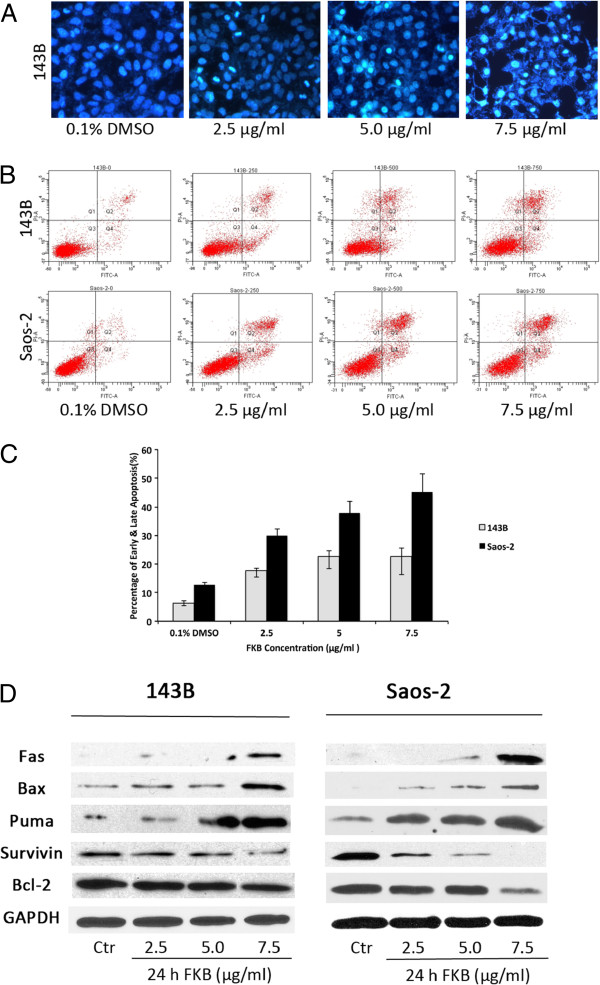
The apoptotic effect of FKB on OS cells. A, 143B cells were treated with different concentrations of FKB for 24 h. Apoptosis was evaluated by DAPI staining. B, 143B and Saos-2 cells were stained with annexin V and propidium iodide and analyzed by flow-cytometry. C, The chart illustrates the results from three separate experiments of flow-cytomety. D, FKB treatment induced the expression of Fas, Bax, Puma, and decreased Survivin and Bcl-2 expression. Cells were treated for 24 h and protein was resolved by SDS-PAGE with GAPDH as a control.